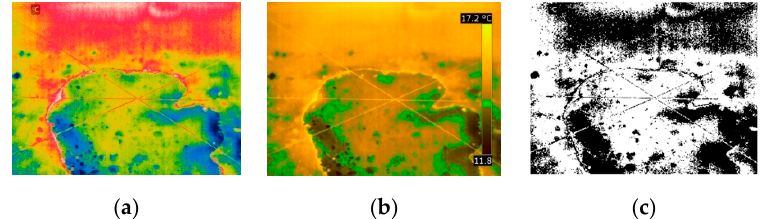
Figure A5. Image result as QIR in ( a ) processed with FLIR software (Yellow scale) in ( b ), and the result of the Otsu’s method in ( c ). Test ID: